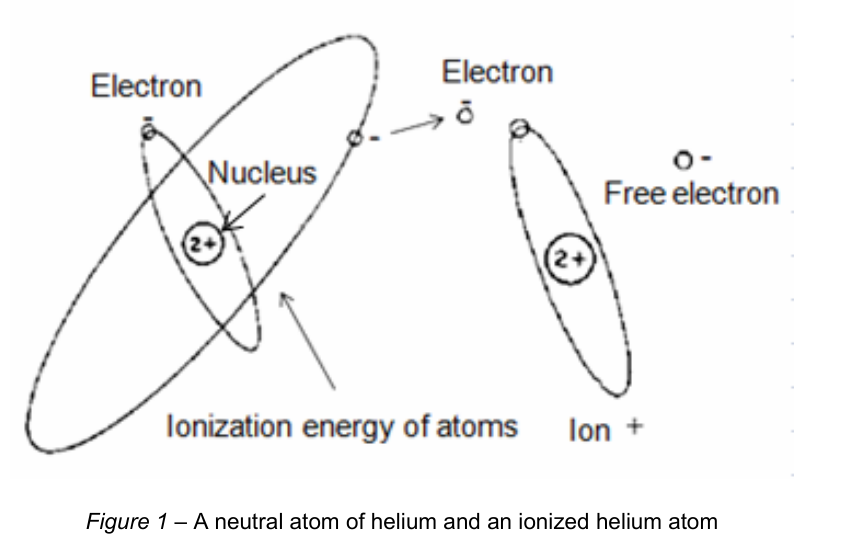
Figure 1 – A neutral atom of helium and an ionized helium